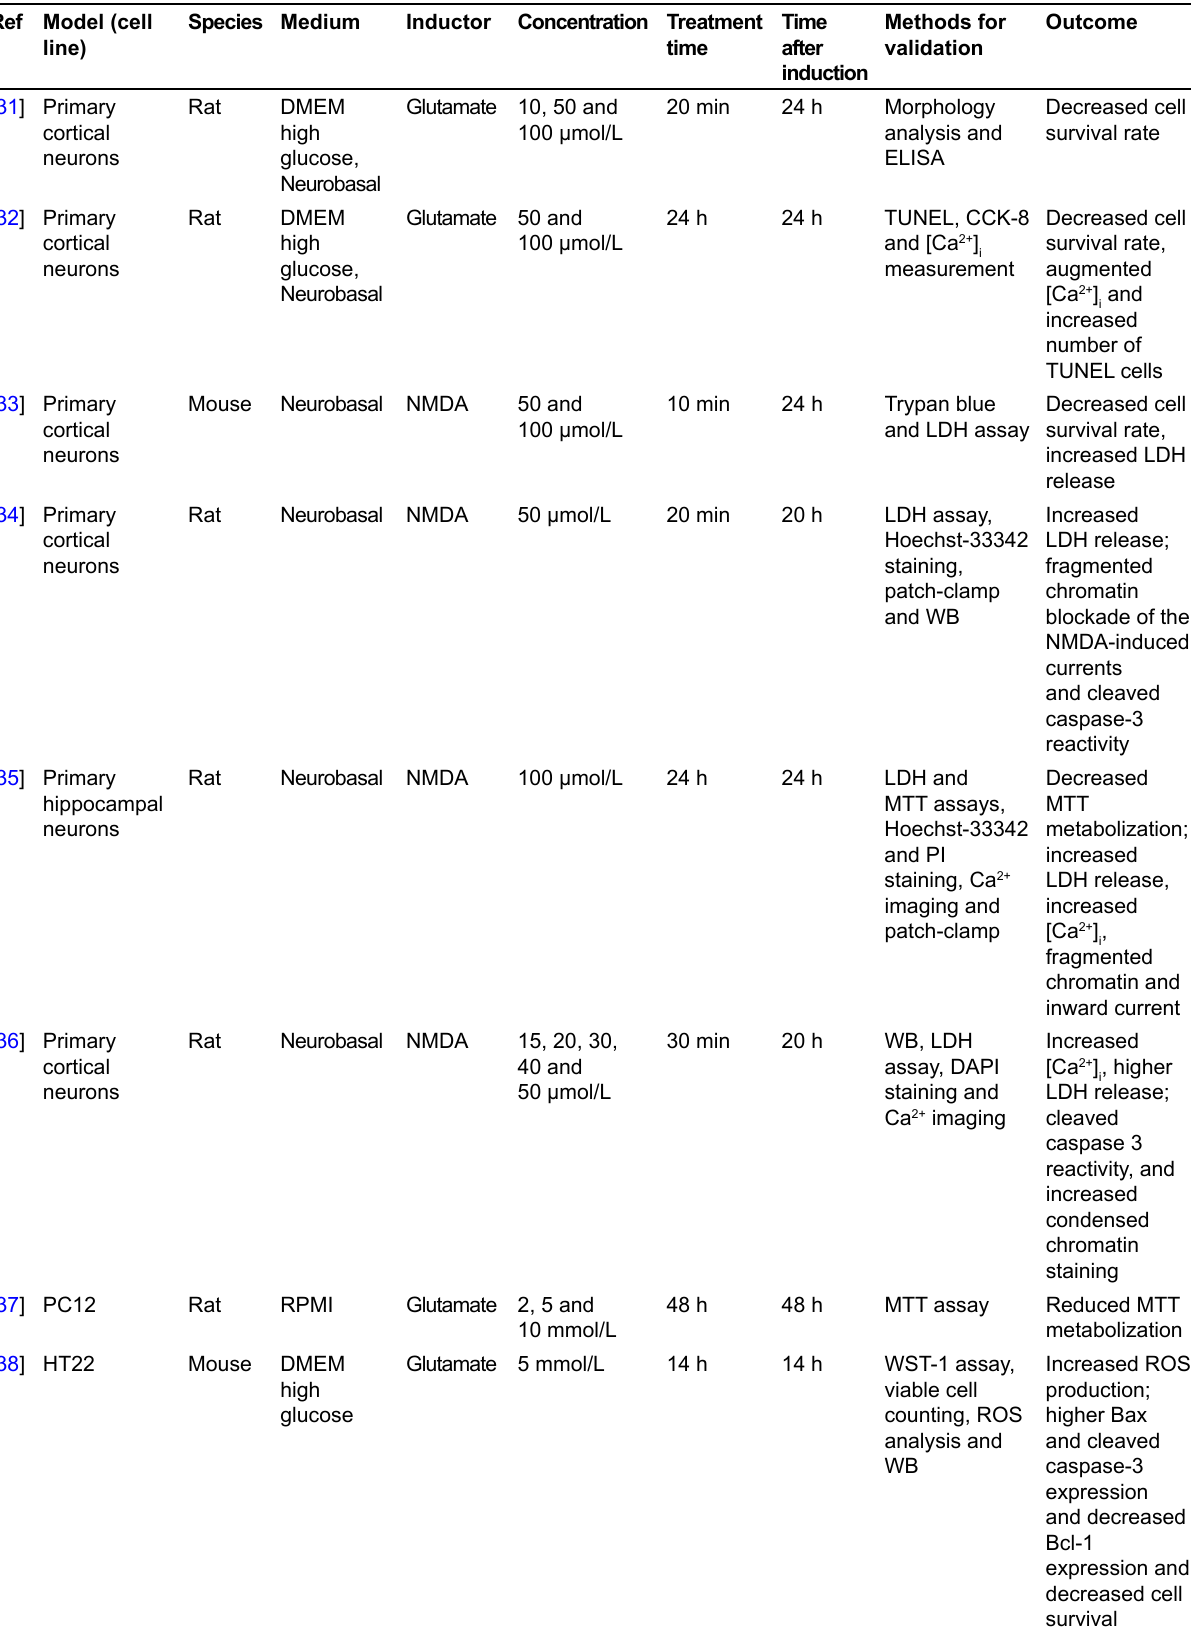
Table 1. Experimental aspects used in published excitotoxicity papers Ref Model